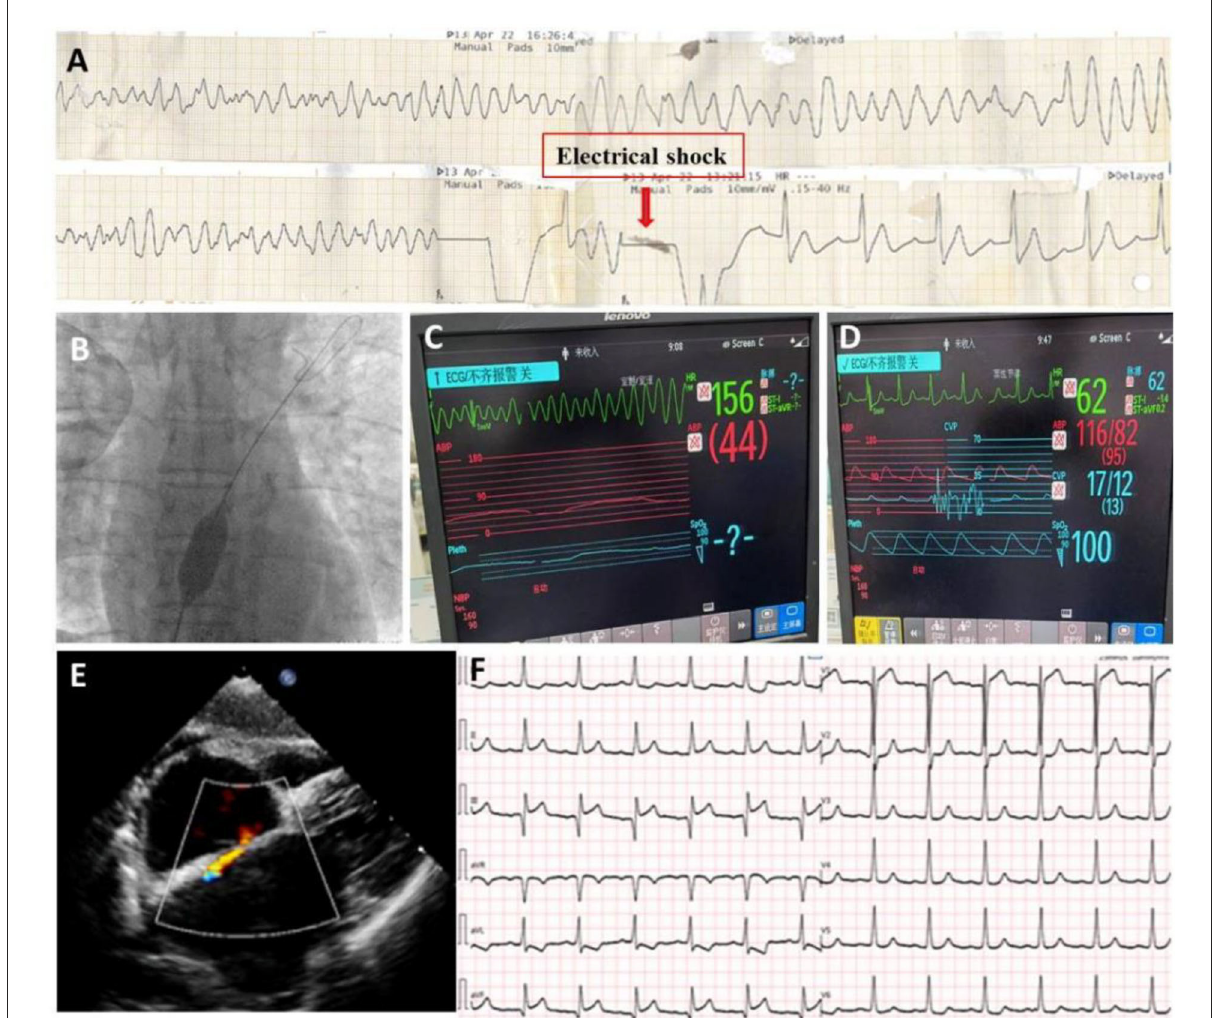
FIGURE4 After stents implantation in LAD, patient still suffered from ES attack (A) ; A procedure of interatrial shunting was performed (B) ; The ES continues during procedure (C) ; but stopped immediately after the creation of shunting (D) ; TTE demonstrated s 9mm interatrial shunting (E) . Follow-up ECG showed sinus rhythm except for a slight ST elevation in II, II, and aVF leads (F) .